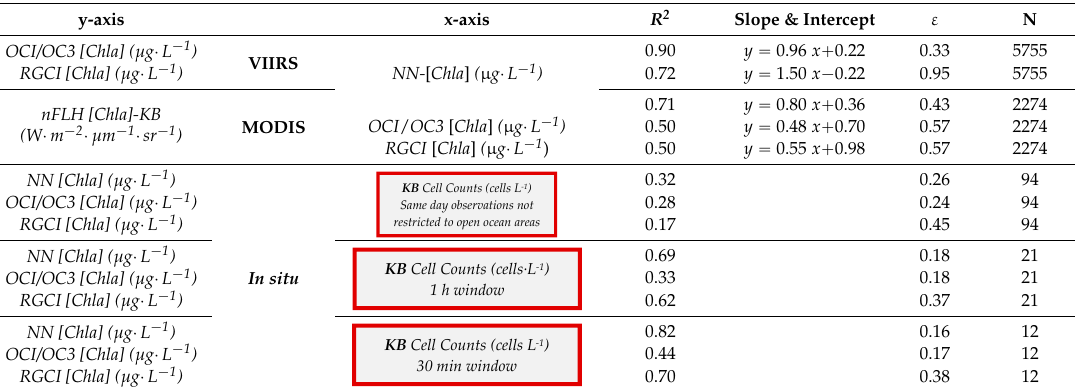
Figure 15. Shows the match-ups falling within the ½ h window, with both filter thresholds. Table 1 below shows summary table of retrieval comparisons, in situ results and KB thresholds criteria applied. Table 1. VIIRS, MODIS-A comparisons and in situ results.